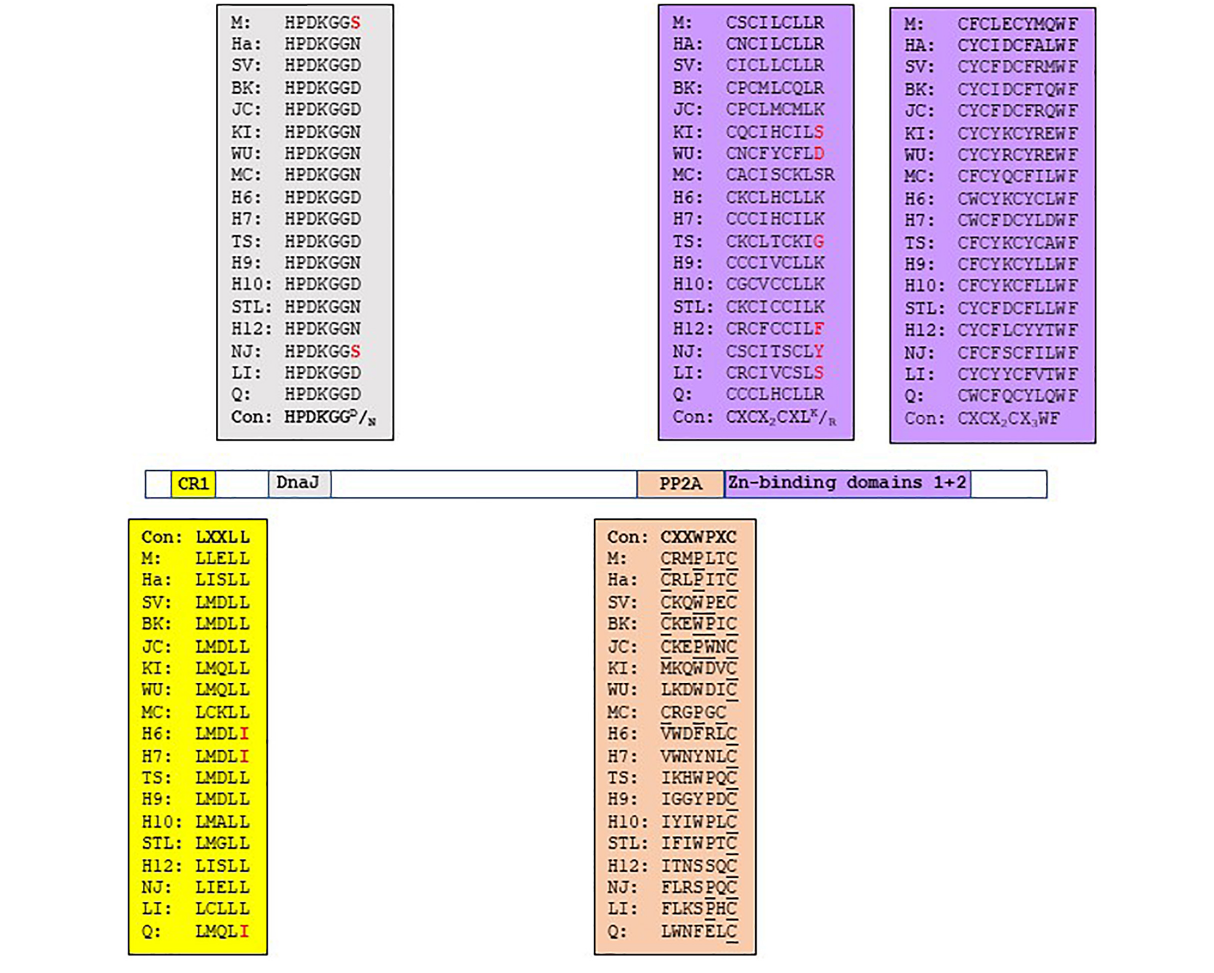
FIGURE 2 | Functional domains in the sT-ags of HPyVs. The amino acid sequence of the functional domains is given in the corresponding colored box. See legend Figure 1 for